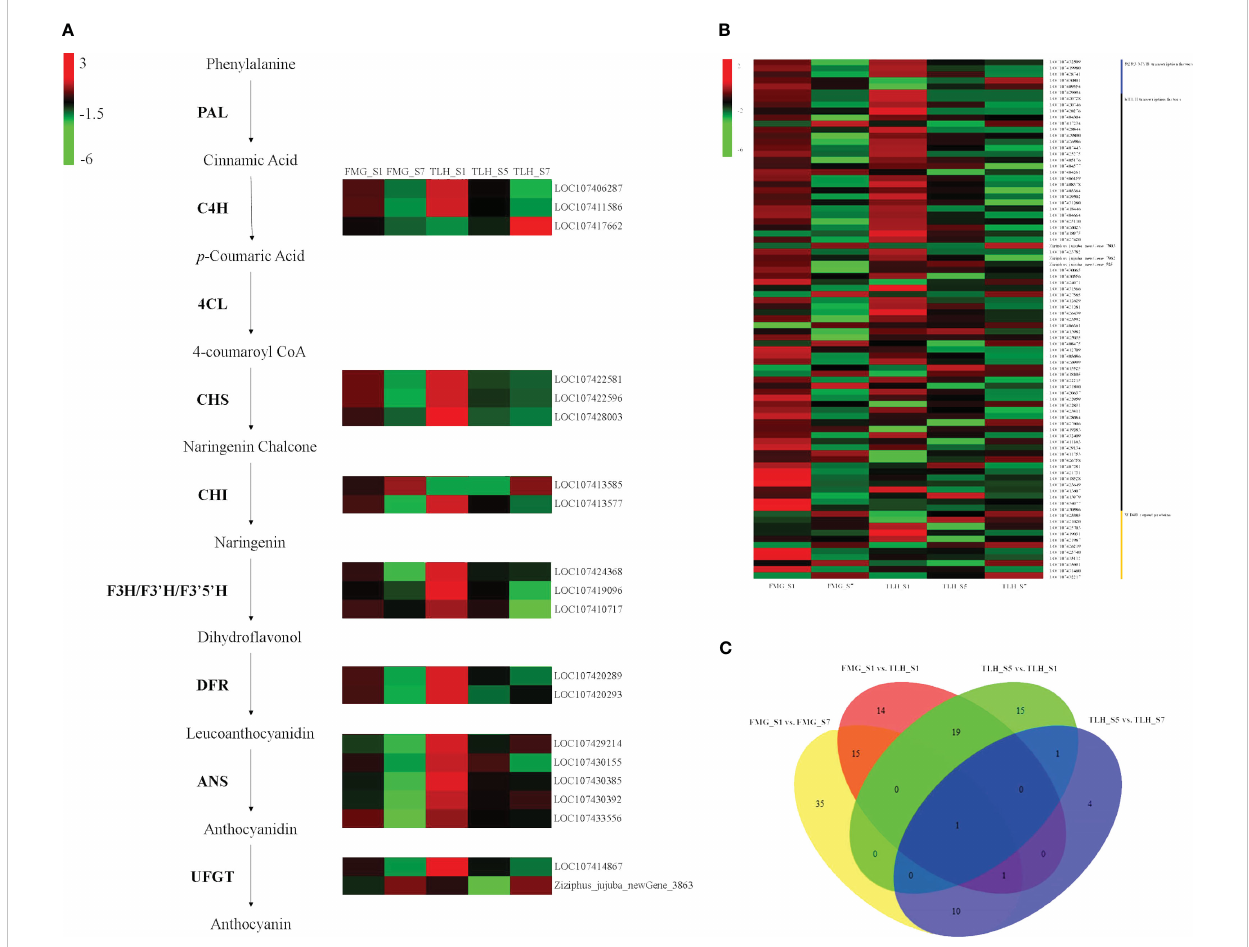
FIGURE 3 Transcriptome analyses of the peels of FMG and TLH. (A) Heatmap of differentially expressed anthocyanin structural genes. (B) Heatmap of differentially expressed R2R3-MYB , bHLH , and WD40 genes. (C) Venn diagram showing the number of differentially expressed R2R3-MYB , bHLH , and WD40 genes in FMG_S1, FMG_S7, TLH_S1, TLH_S5, and